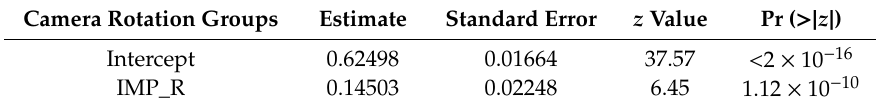
Table 5. The results of the logistic regression analysis by investigating the camera rotation